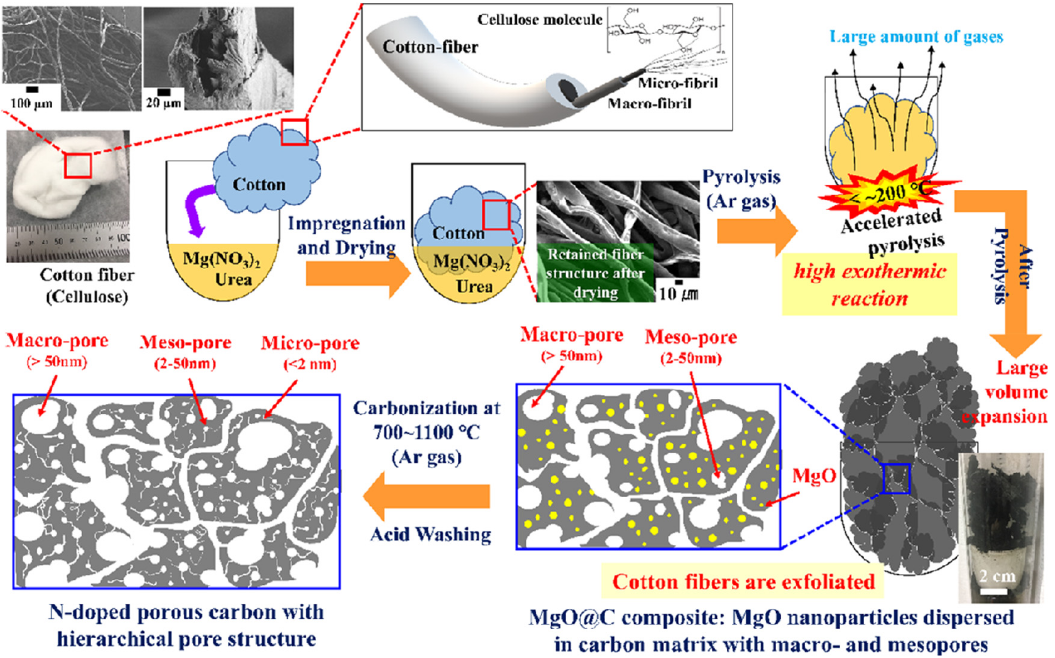
Figure 4. Schematic diagram of the preparation of N-doped porous carbon particles with a hierar- chical pore structure from cellulose. Reprinted with permission from [108]. Copyright 2019 American Chemical Society.